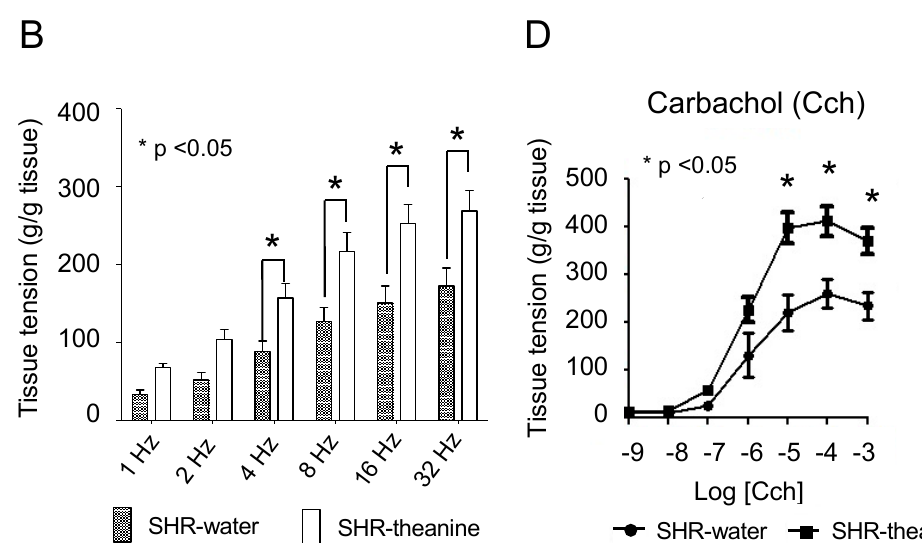
Figure 4. Comparison of bladder strip contractility in response to various stimuli: ( A ) comparison of bladder strip contractility in response to KCl, ( B ) electrical field stimulation, ( C ) ATP, and ( D ) carbachol between SHR treated with water and treated with L -theanine. Mean contractile responses to 80 mm KCL or 1 mm ATP, electrical field stimulation from 4 Hz to 32 Hz, or carbachol concentration from 10 µ M to 1 mM were significantly larger in the SHR–theanine group than in the SHR–water group. Data are presented as mean ± standard error of the mean. * Statistical significance at the p < 0.05 level.